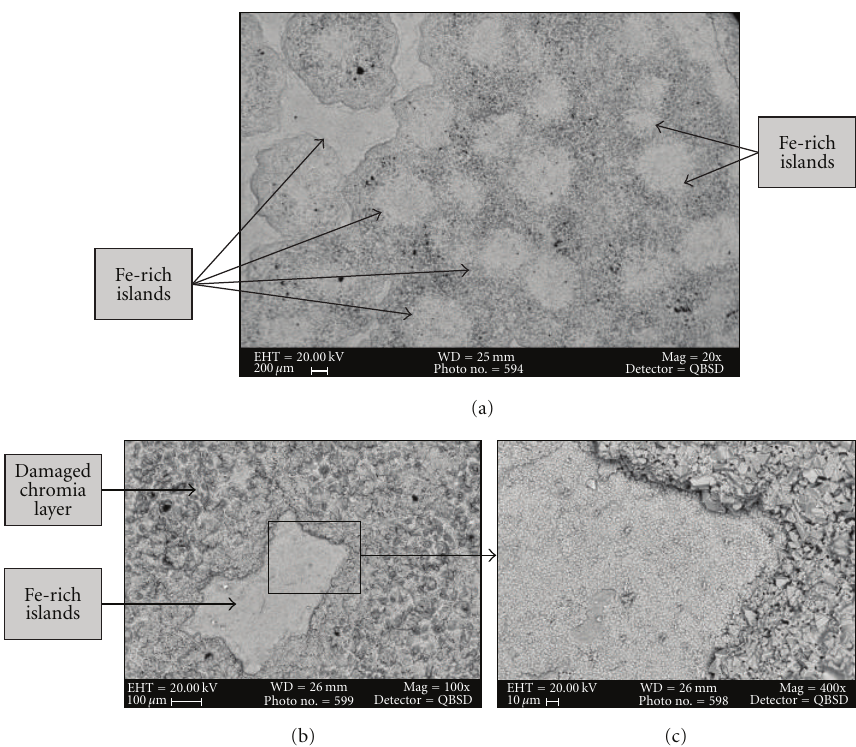
Figure 5: General aspect of the oxidized AISI 304 surface at T = 1000 ◦ C and after 100 hours, (a) Fe-rich islands at magnification 20x, (b) border line of an island at magnifications 100x and (c) 400x.